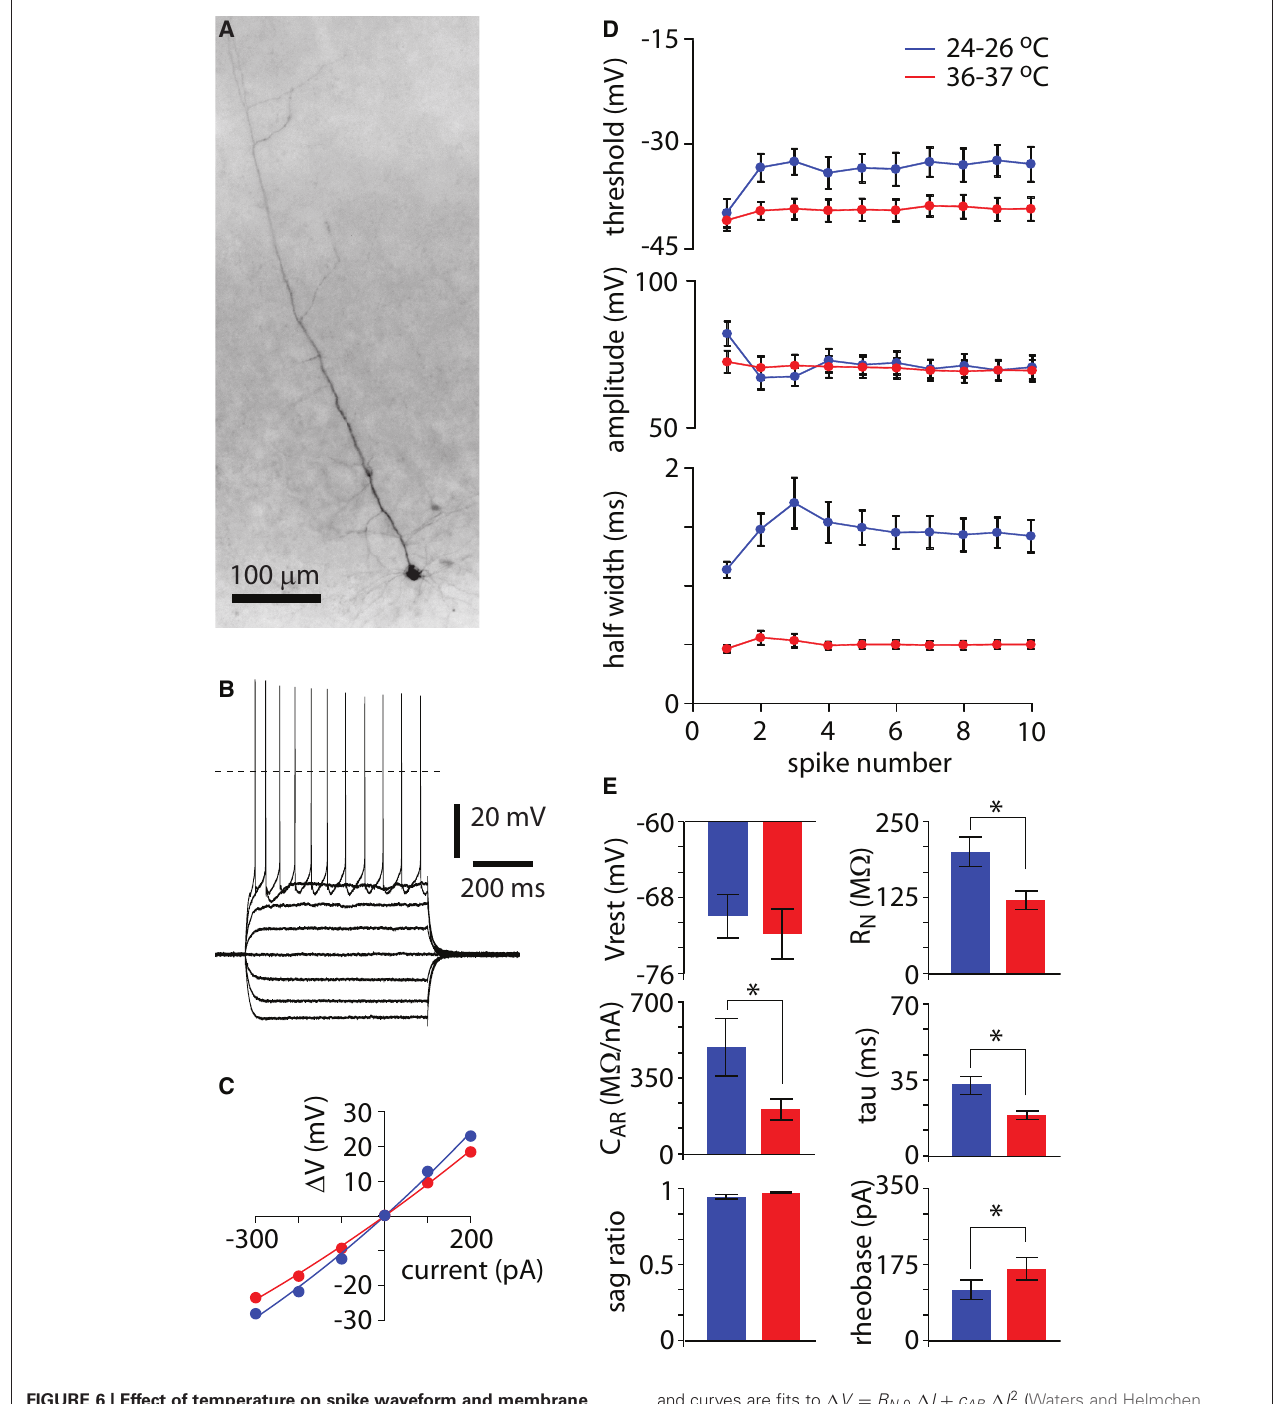
FIGURE 6 | Effect of temperature on spike waveform and membrane properties in layer 6 pyramidal neurons. (A) Widefield fluorescence image of a layer 6 pyramidal neuron, filled with Alexa 594 via the recording pipette. Note that the apical dendritic tree is intact. (B) Voltage responses to somatic current injection in the neuron in panel A . 100pA current steps from − 300 to + 400pA at 35 ◦ C. (C) V-I curves at 26 (blue) and 35 ◦ C (red) for the neuron in panel A , generated from results such as that in panel B . Points denote steady-state voltage measurements